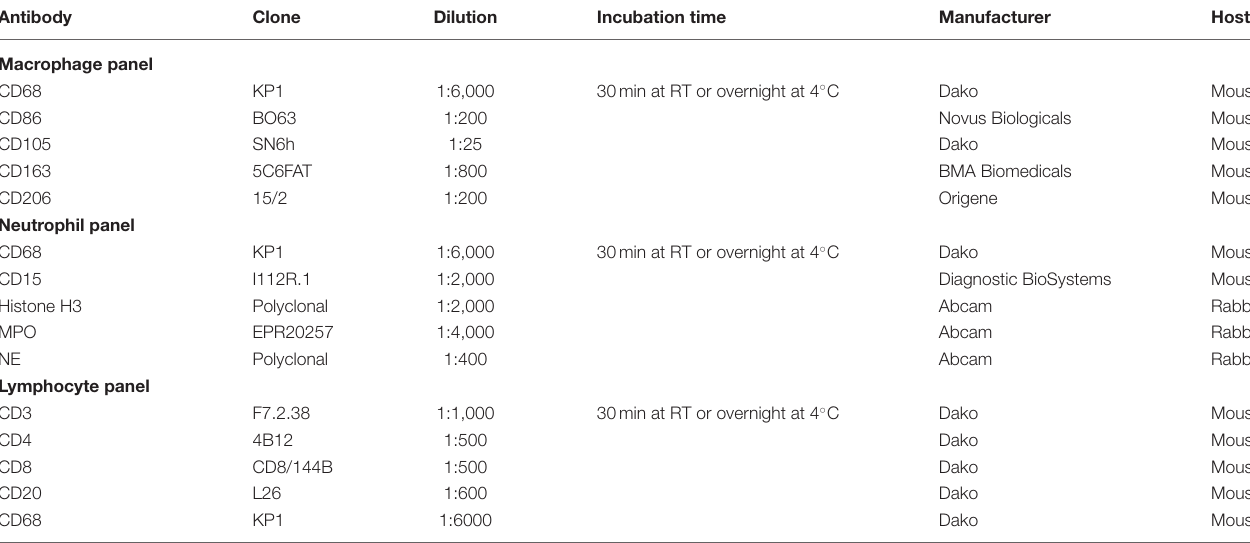
TABLE 1 | List of monoclonal